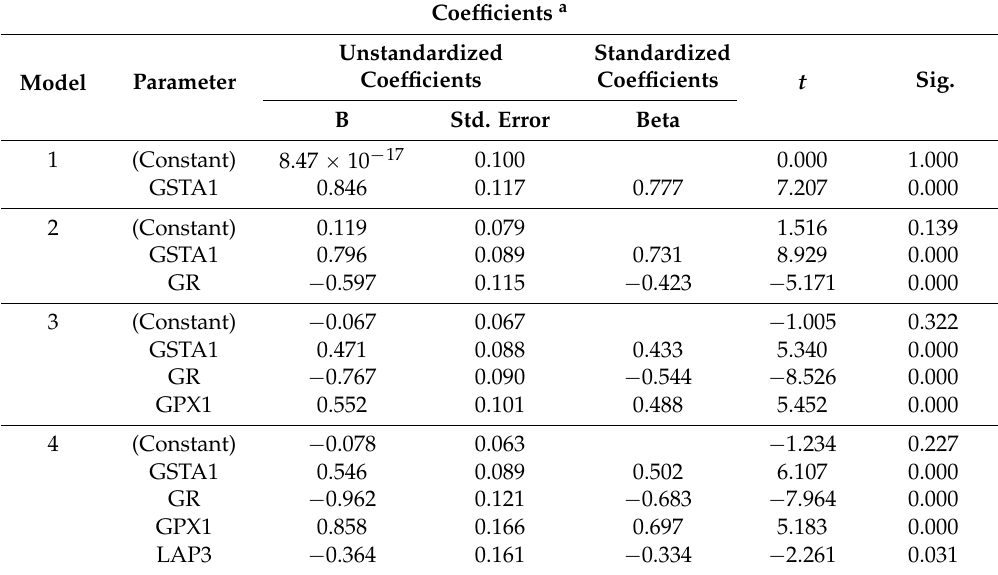
Table 1. Evaluation of the fourth model.